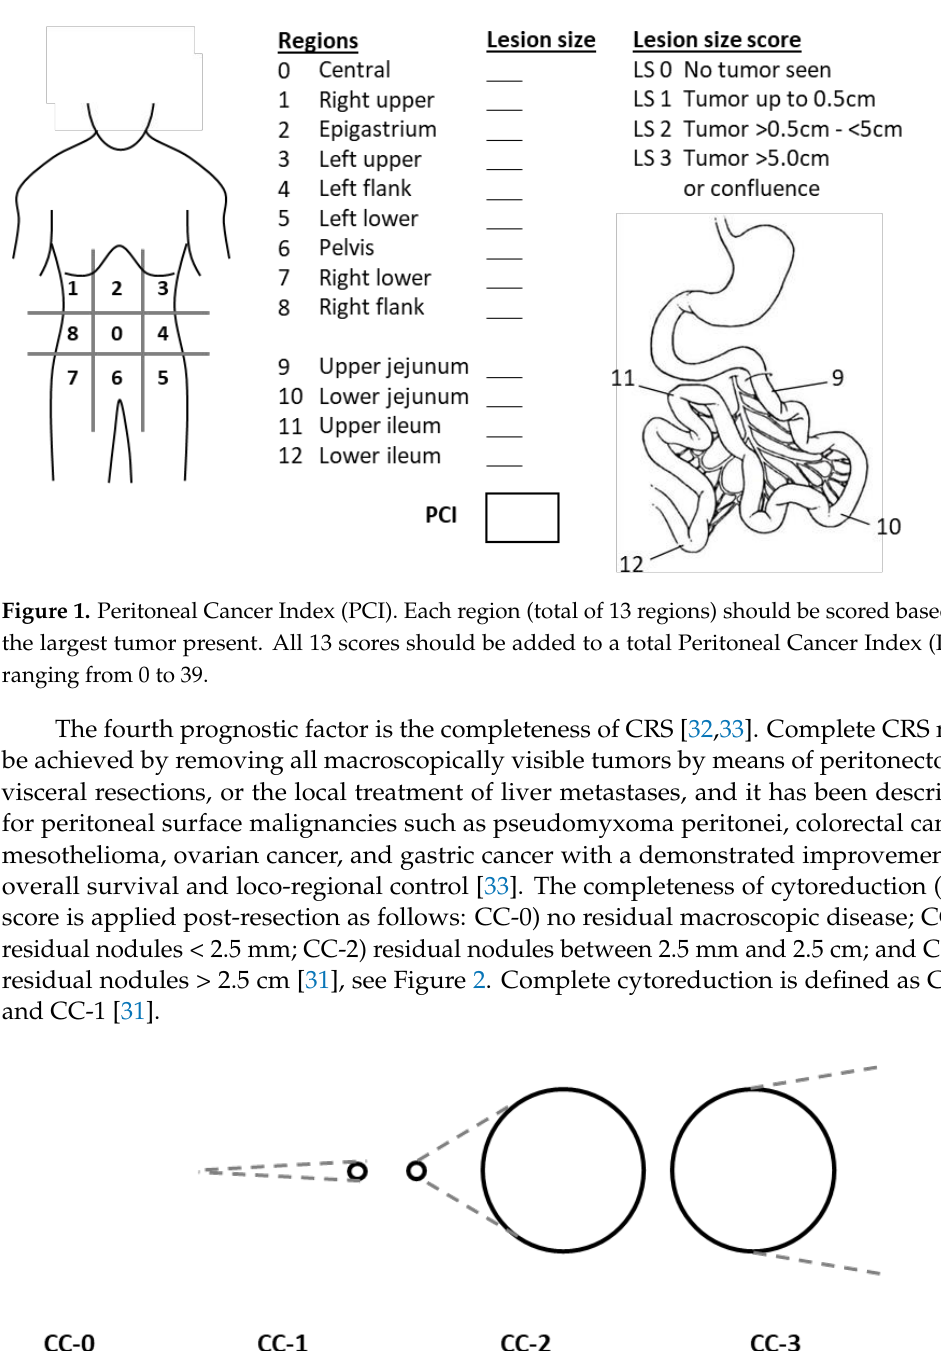
Figure 2. CC-score: completeness of cytoreduction after surgery .